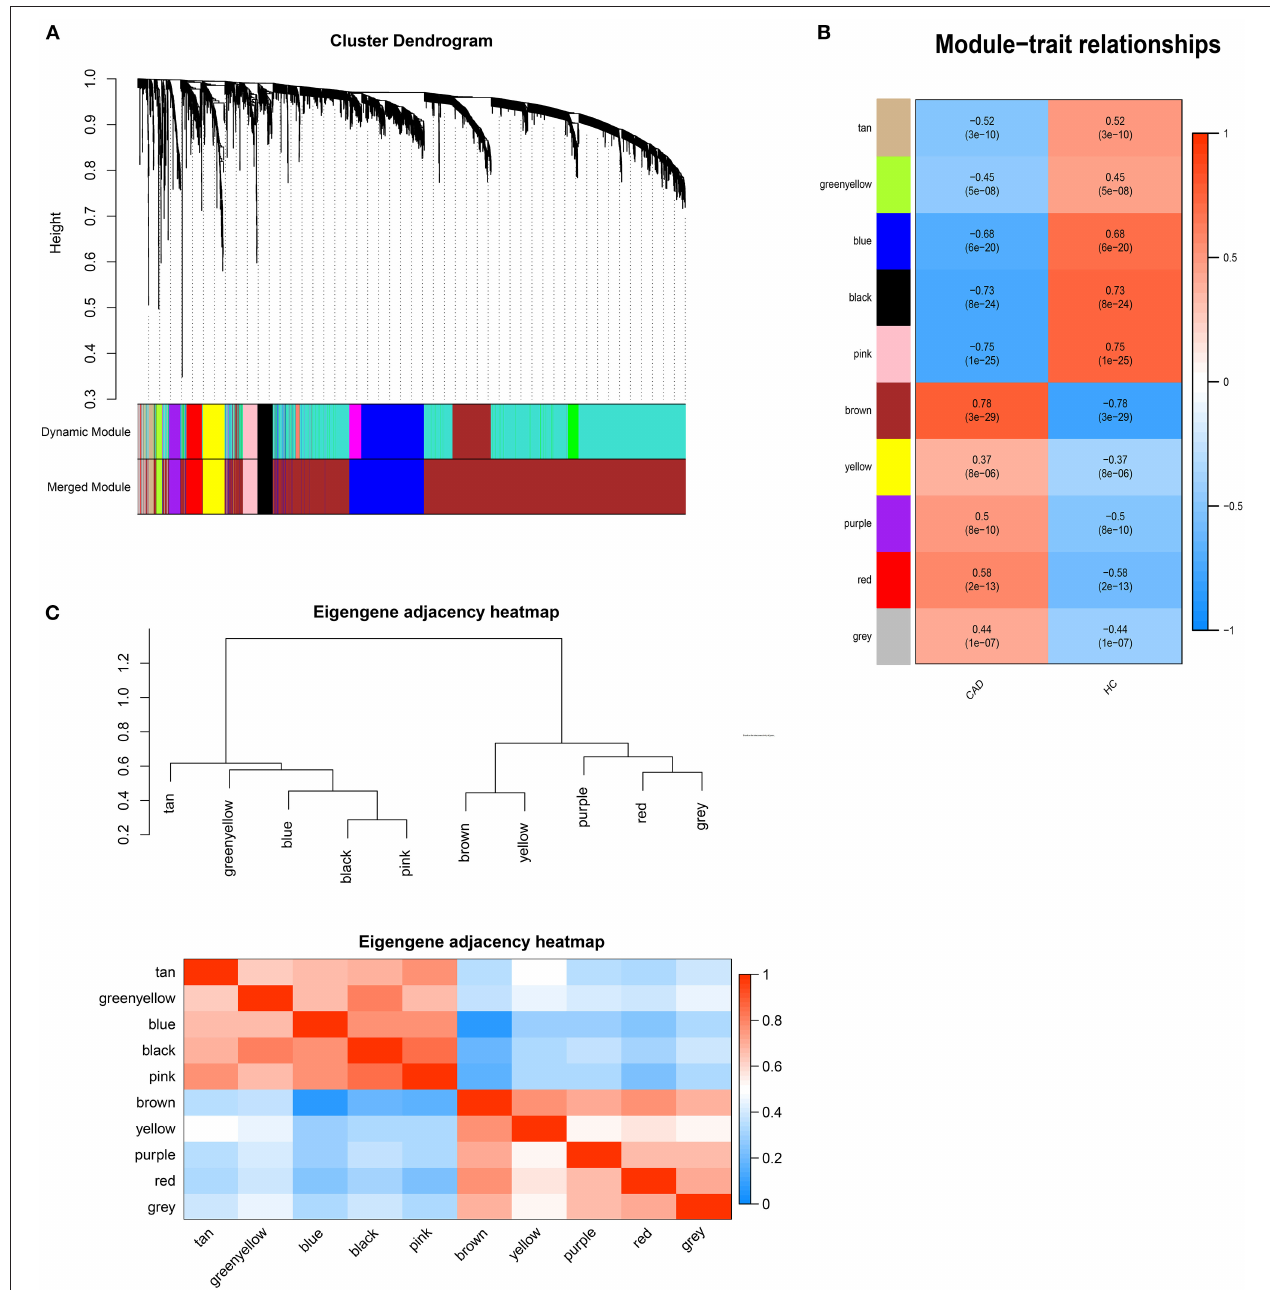
FIGURE 1 | Weighted genes correlation network analysis. (A) The dendrogram of differentially expressed genes. (B) The heatmap of module-trait correlations. Blue represents negative correlation, and red represents positive correlation. (C) The clustering heatmap between modules. Red means closer similarity, and blue means farther